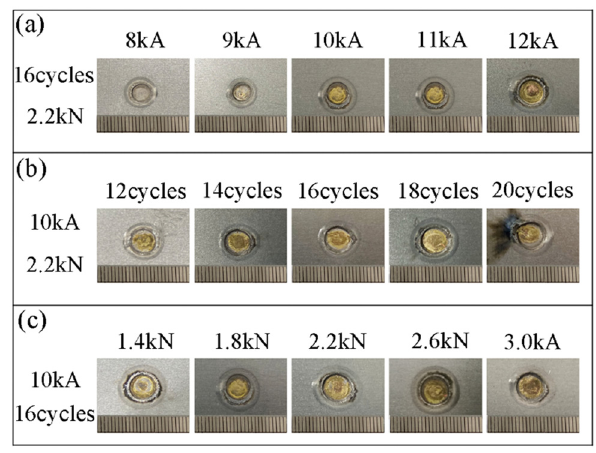
Figure 2: Macrophotographs of the resistance spot welded joints in di ff erent con fi gurations: ( a ) welding current, ( b ) welding time, and ( c ) electrode